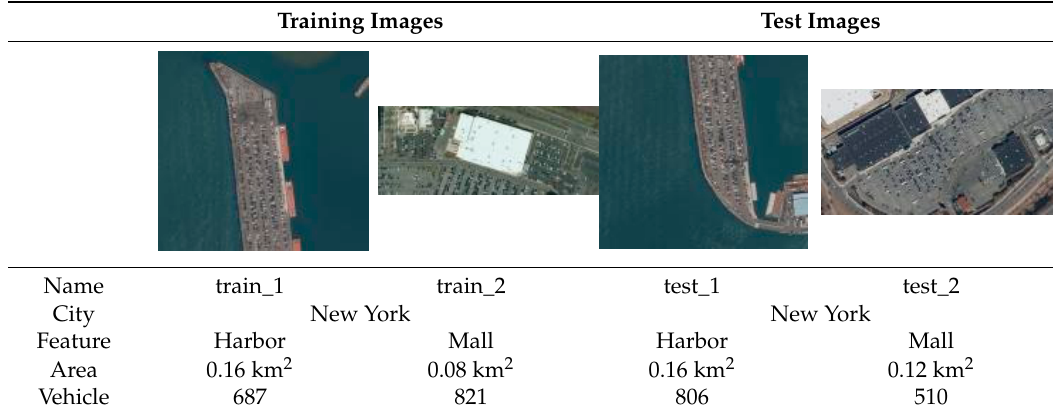
Table 1. Training and test images.